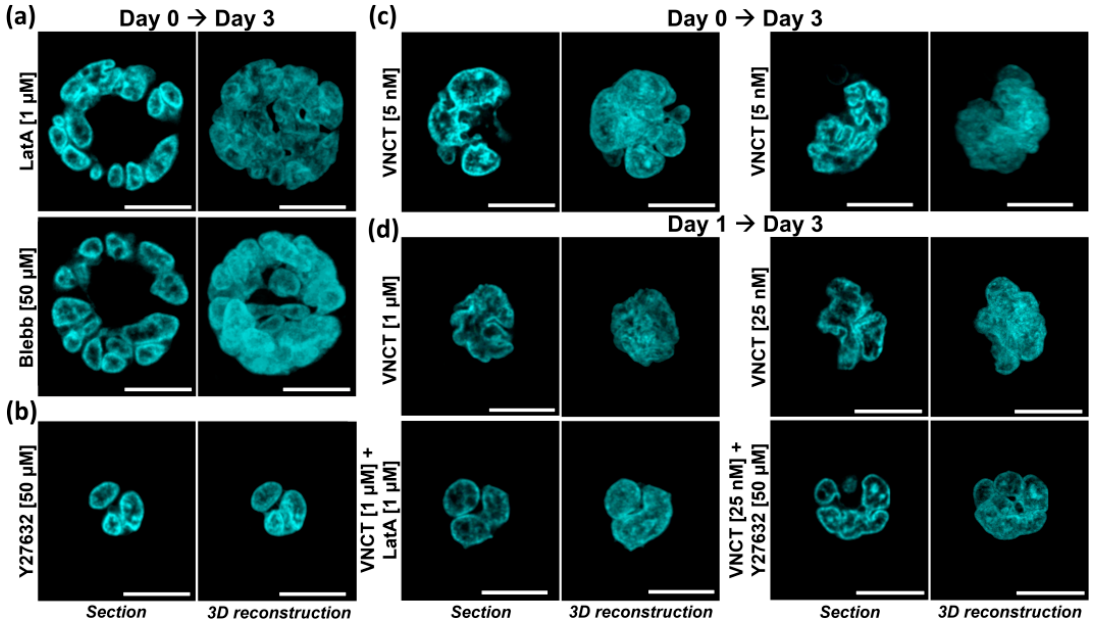
Figure 2. Effect of cytoskeleton on lobulation and segmentation. ( a ) Representative pictures of live-cell nuclear staining in Day 3 iHL60 treated for 3 days with LatA or Blebb, showing giant cells with multiple lobulated and segmented nuclei. ( b ) Representative picture of live-cell nuclear staining in Day 3 iHL60 treated for 3 days with ROCK inhibitor Y-27632. ( c ) Nanomolar concentrations of vincristine (VNCT) are 97% lethal when added at Day 0 of differentiation, but surviving cells display giant polyploid nuclei, either lobulated and segmented (left) or presenting a “wrinkled” morphology (right). ( d ) iHL60 treated at Day 1 are more resistant to microtubules (MTs)-depolymerization given early cell-cycle exit, and simultaneous microfilament (MF)-disassembly (left) or ROCK inhibition (right) rescue nuclear wrinkling and allow nuclear lobulation and segmentation. (All images up-to-scale for comparison, scale bar = 10 μ m).